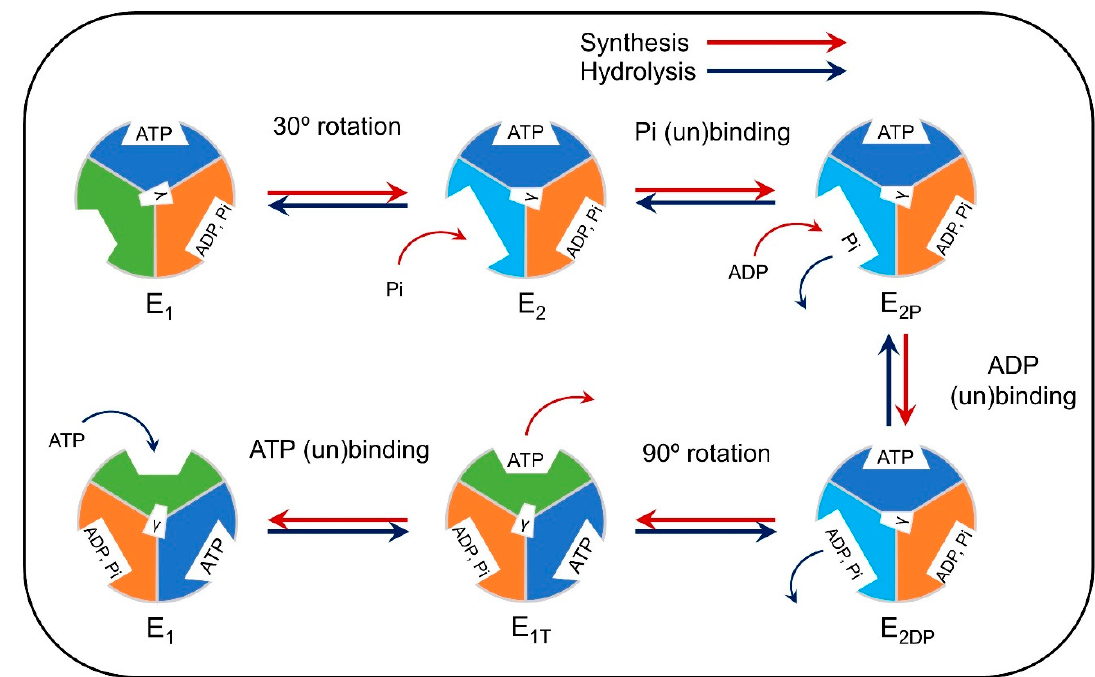
Figure 7. Schematic of the reaction cycle of the F 1 subcomplex for ATP synthesis and hydrolysis. After one cycle, the ATPase returns to an equivalent configuration but is rotated by 120°. The color and shape of each catalytic binding site indicate their structure with dark blue, orange, green, and light blue corresponding to structures β TP , β DP , β E , and β HC , respectively [14]. The sequence of ATP synthesis is shown by red arrows, and ATP hydrolysis is indicated by blue arrows. The orientation of the γ subunit is depicted at the center of the synthase.